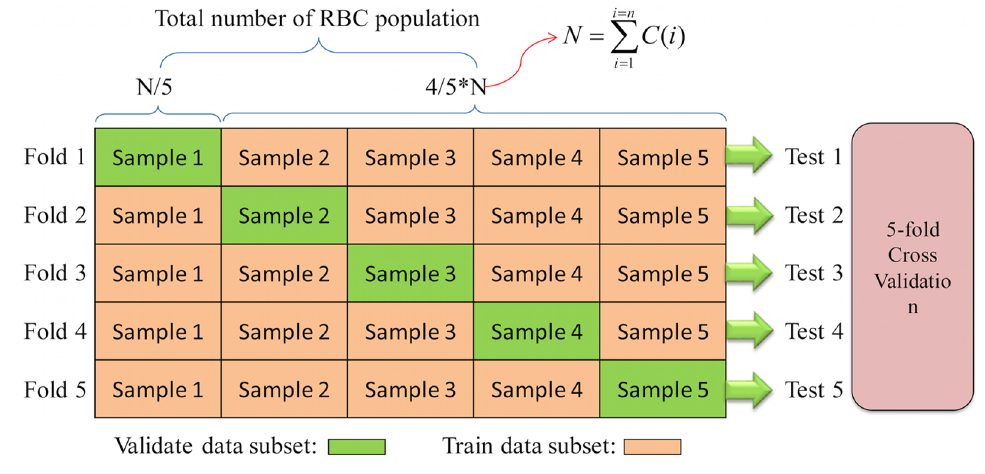
Fig 11. Evaluation procedure for 5-fold cross